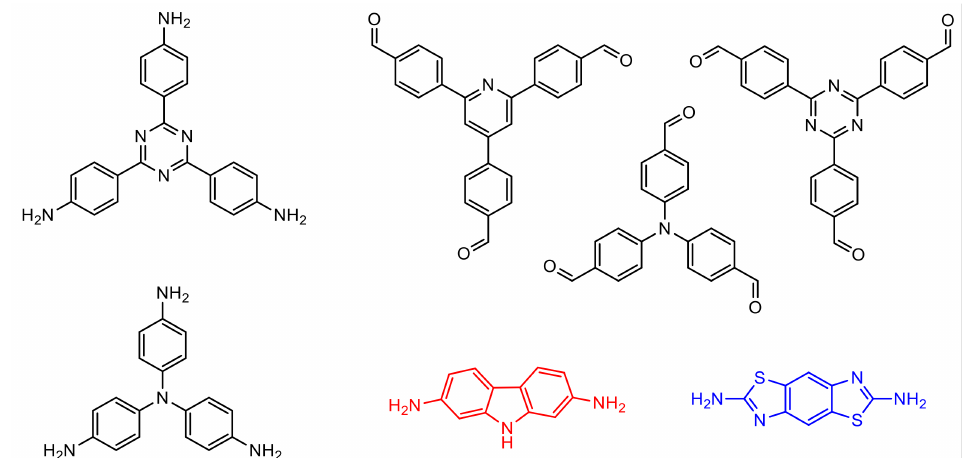
Figure 5. Structures of (black) the monomers used by El-Mahdy et al. [48]; structures of the diamines used in (red) Cz-COF and (blue) Tz-COF syntheses.